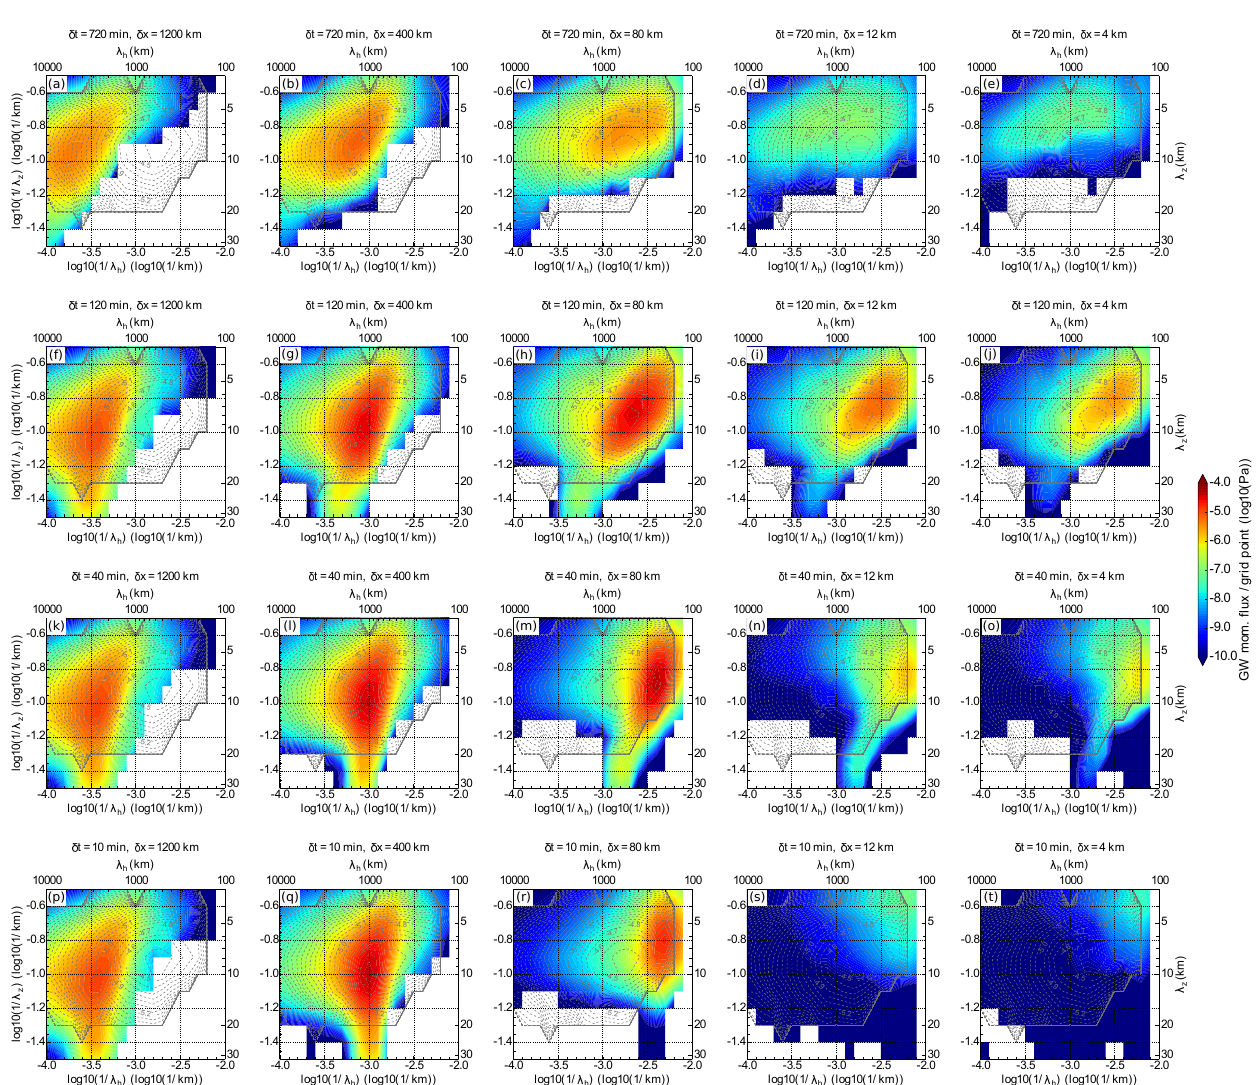
Figure 1. A systematic survey of the CGWS scheme depending on different spatial and temporal scales of the convective system for July 2006. The color code shows the simulated GWMF spectra of CGWs generated by the Yonsei CGWS scheme, propagated upward to 25km altitude using GROGRAT and filtered according to the observational filter. The dashed contour lines show the spectrum for regions of deep convection observed by